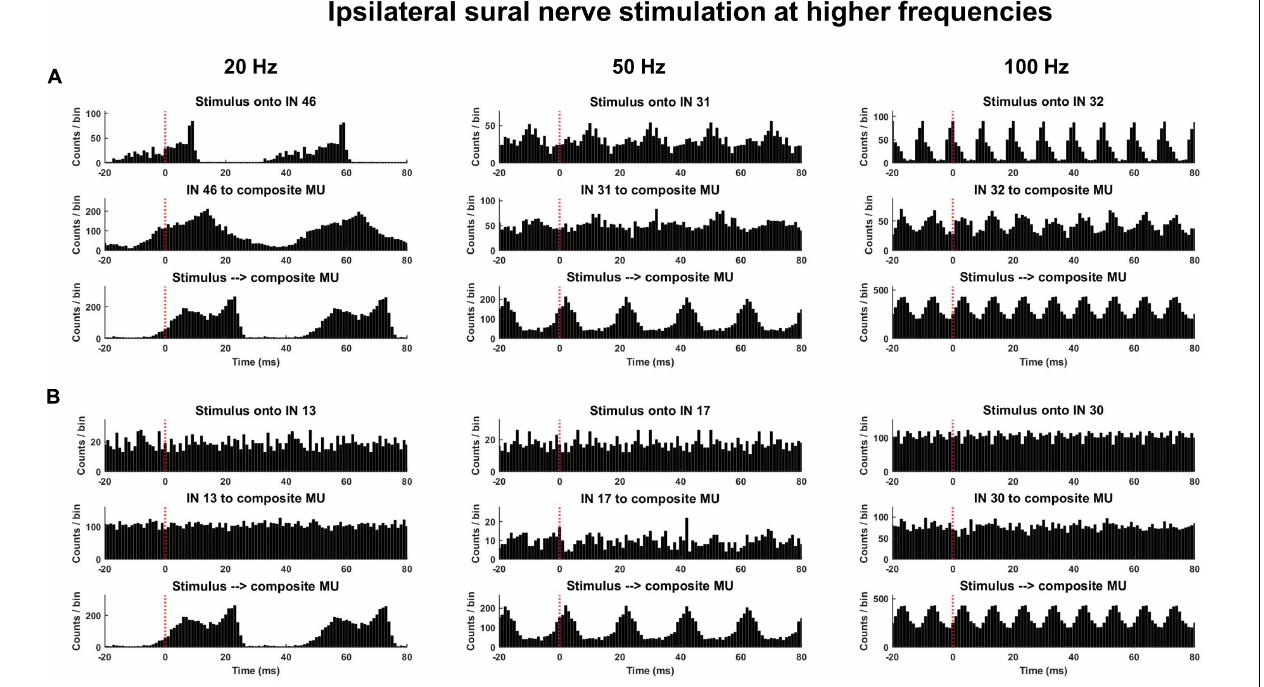
FIGURE 4 | Exemplar peristimulus time histograms during trials of higher frequency ( ≥ 20 Hz) ipsilateral sural nerve stimulation. (A) Clear responses entrained to the stimulus frequency can be observed; however, due to the long latency of the response and short inter-stimulus interval, the type (excitatory or inhibitory) and onset of response cannot be reliably determined from analysis of the PSTH. (B) Illustrates interneurons from the same trial that were not entrained to the stimulus frequency along with composite motor unit spike trains (CST) in response to the stimulus [bottom plots of panels (A,B) are